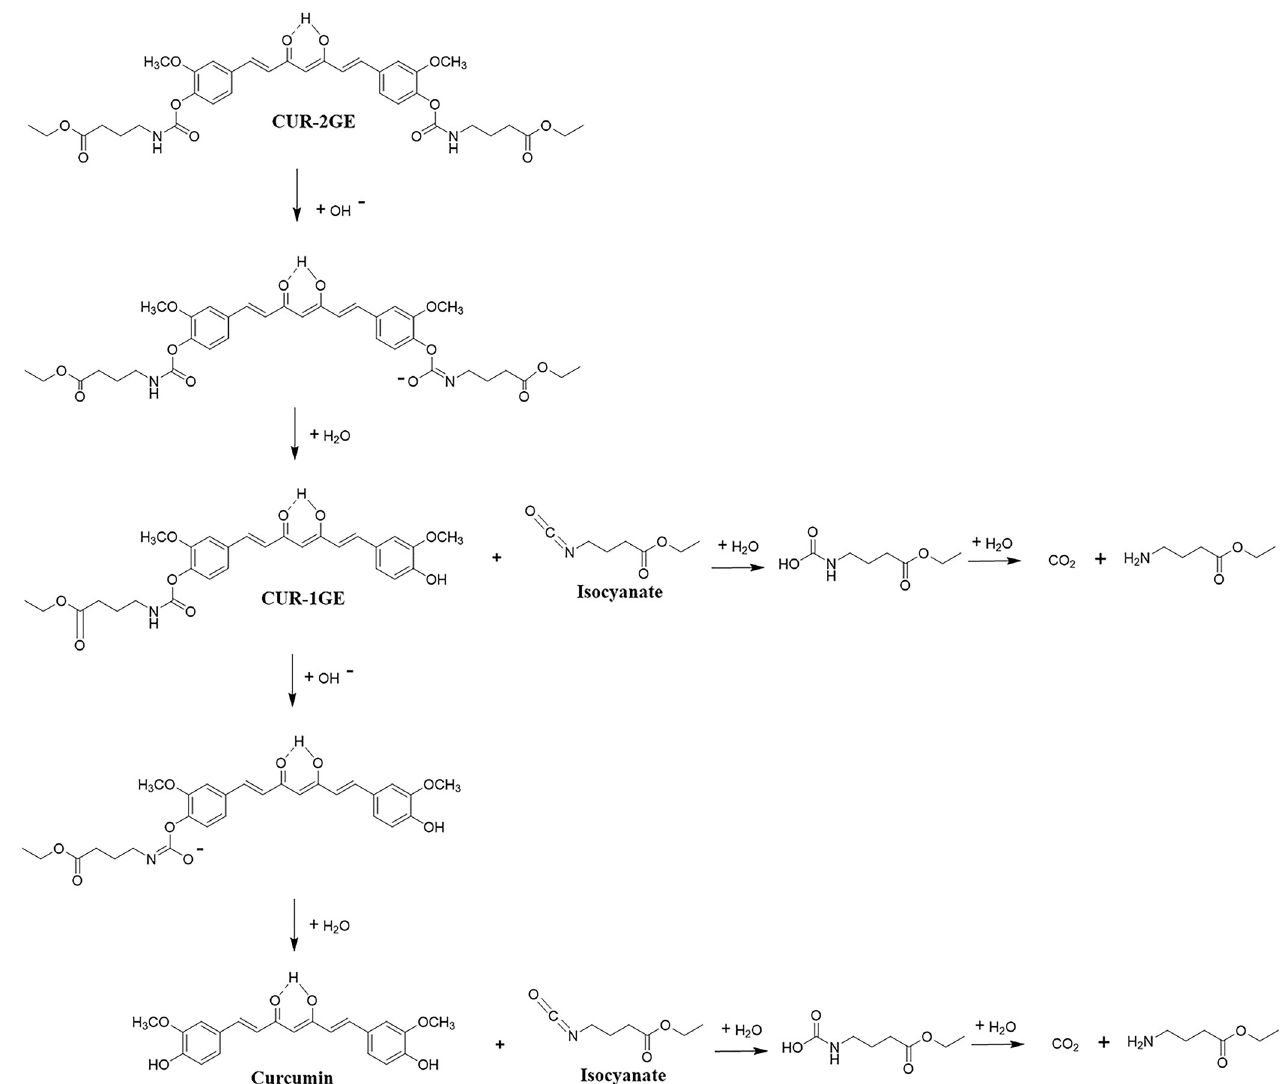
Fig 5. Proposed hydrolysis mechanisms of CUR-2GE in buffers at pH 6.8 and 7.4.